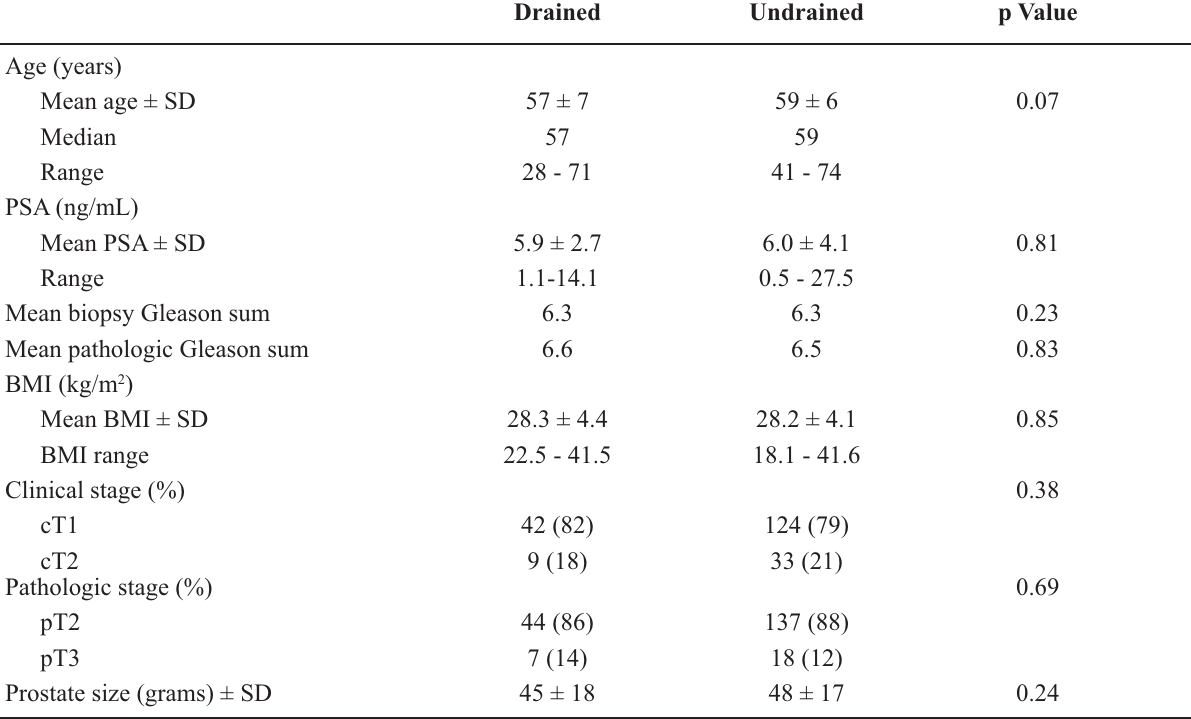
Table 1 – Patient, tumor characteristics.